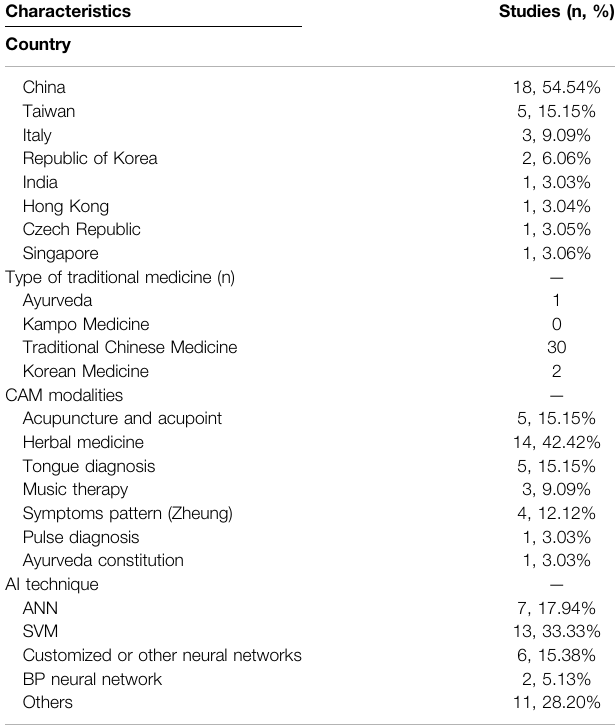
TABLE 1 | Summary of the studies in the